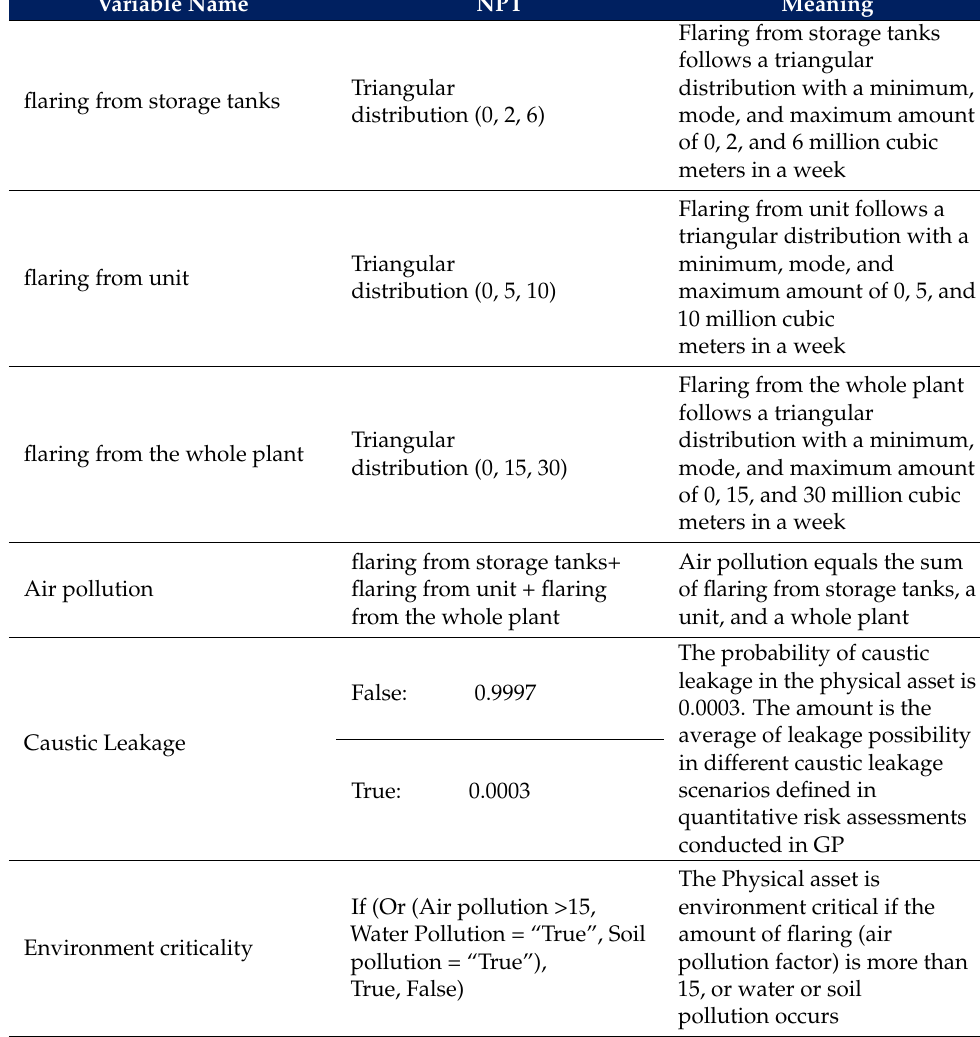
Table 7. NPT of the variables describing environment